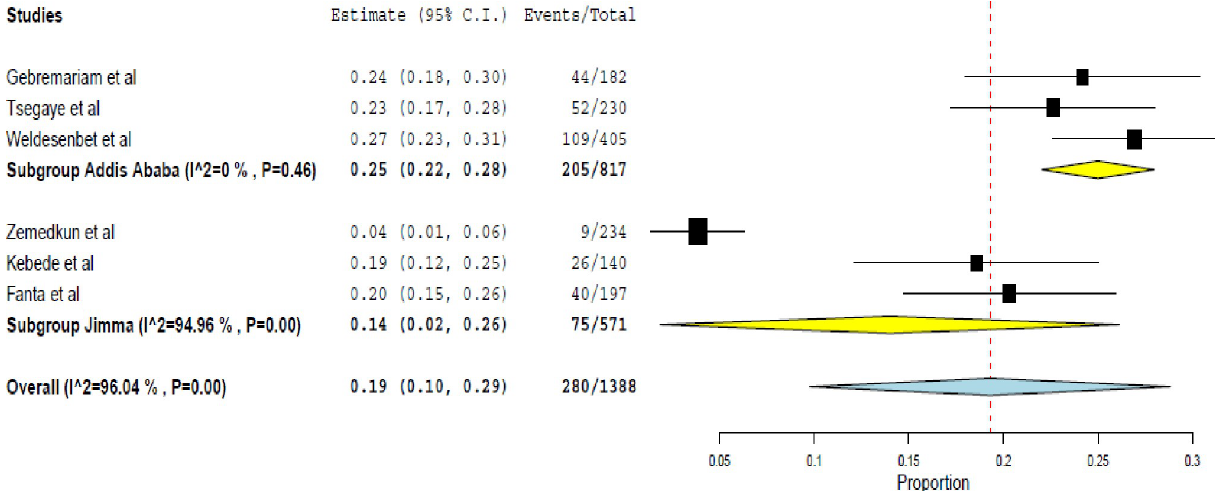
Fig 4. Rate of well-controlled asthma assessed using the GINA symptom control.